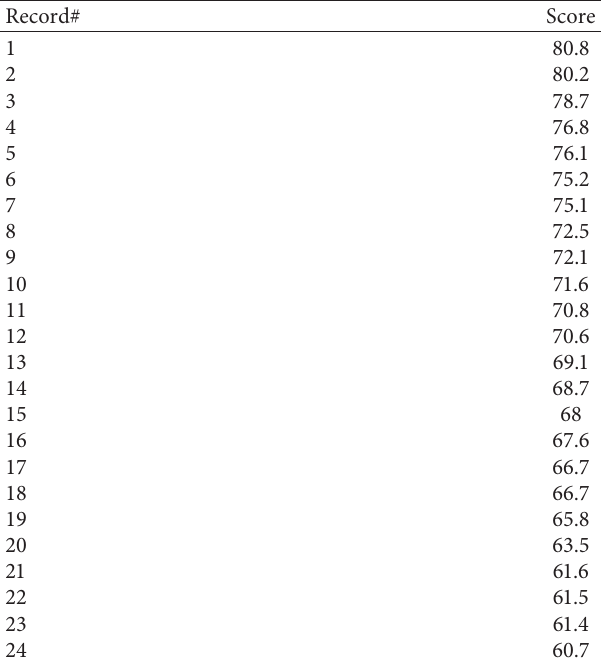
Table 4: Sorted scores of RD − data